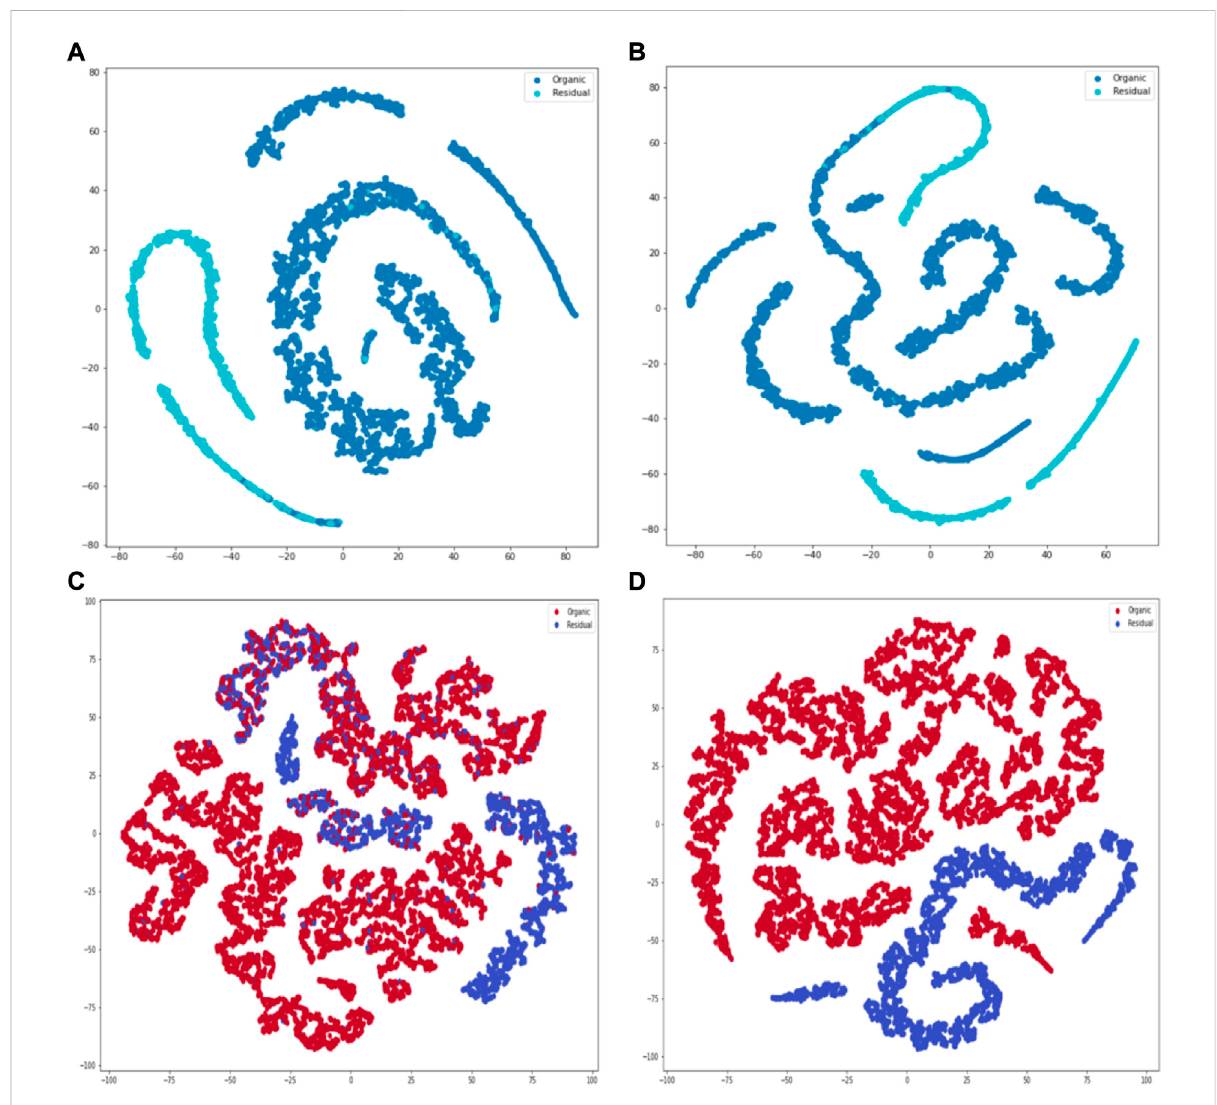
FIGURE 5 A 2-D feature visualization of an image representation of waste images by the method of t-SNE: (A) VGGNet-16; (B) VGGNet-16 with TL; (C) ResNet-50; (D) ResNet-50 with TL; Note: TL was represented to transfer